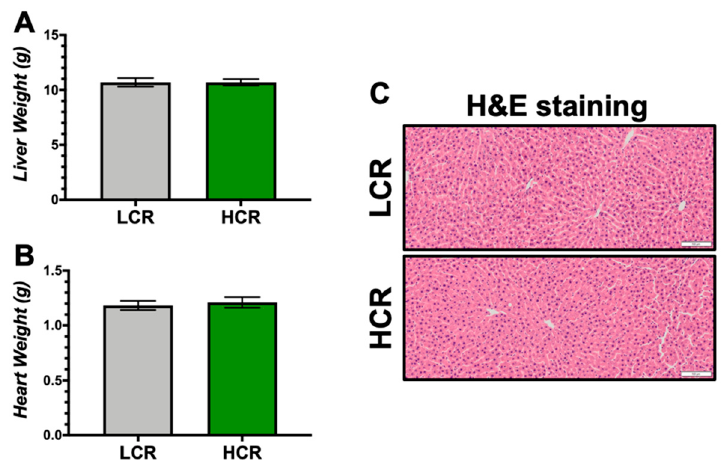
Figure 2. Organ weights and hepatic Hematoxylin and Eosin (H&E) staining in LCR and HCR rats. ( A ) Liver weight. ( B ) Heart weight. ( C ) Representative hepatic H&E staining. Scale bar = 100 µm. n = 9/group.